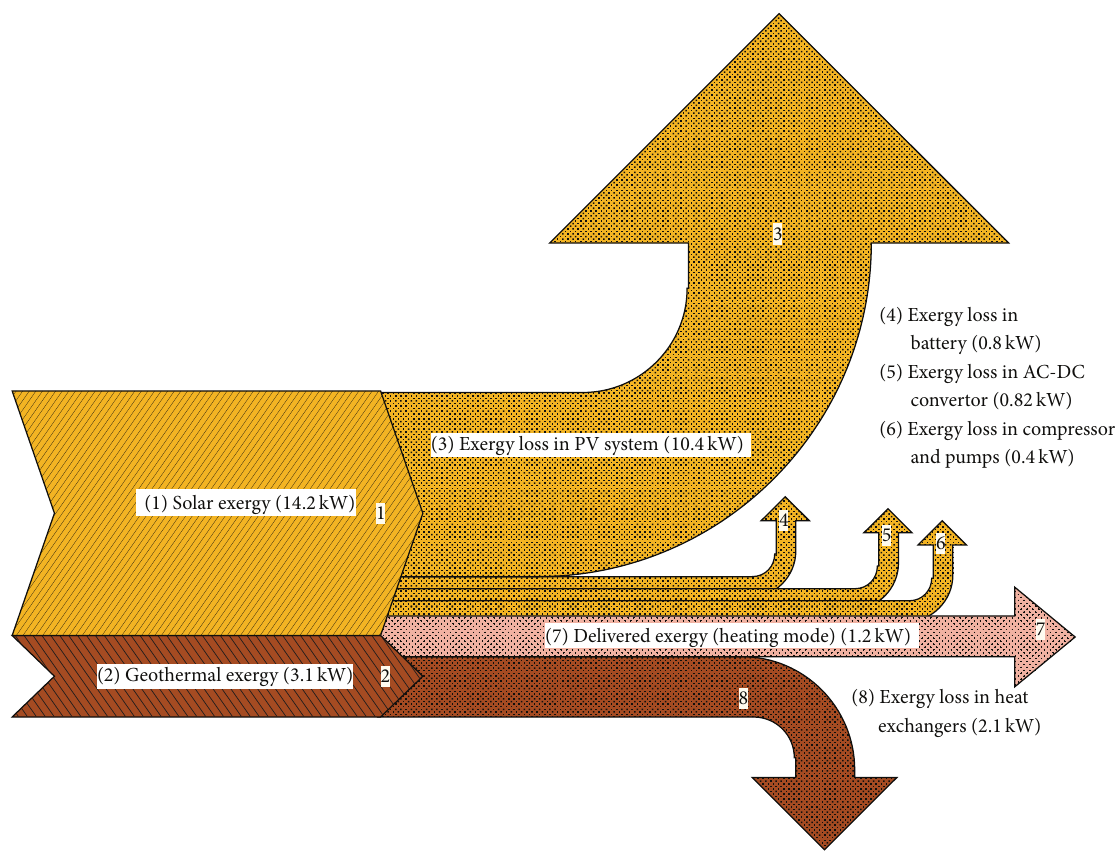
Figure 5: Grassmann diagram for hybrid cycle in heating mode (without scale).